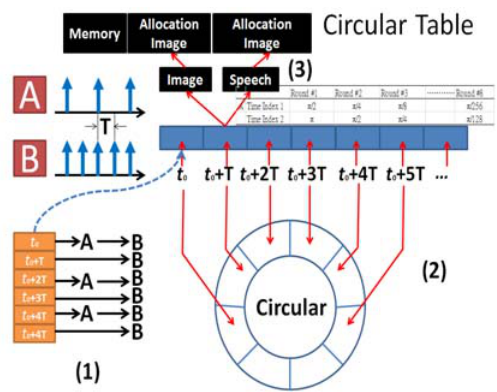
Figure 12. SIN Circular Table.